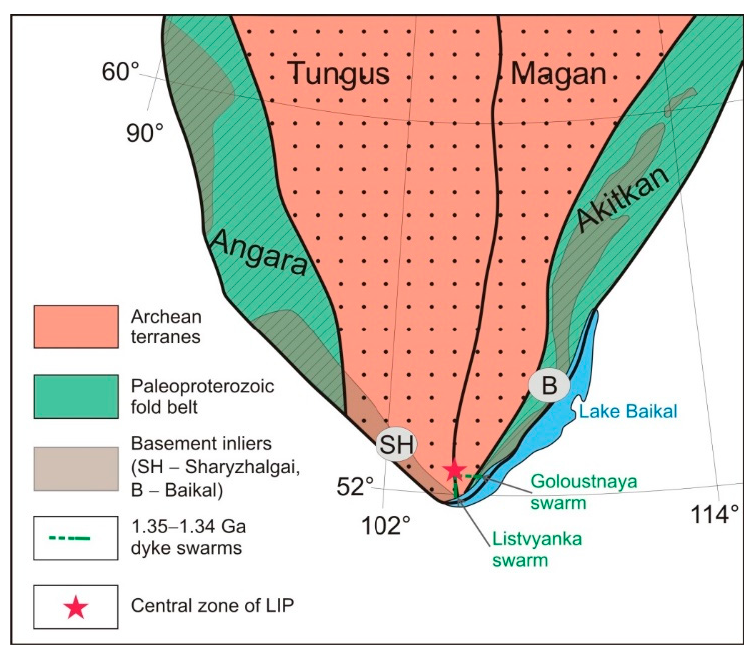
Figure 1. Major tectonic elements of the Irkutsk Promontory of the southern part of the Siberian craton (modified after [26–28]).